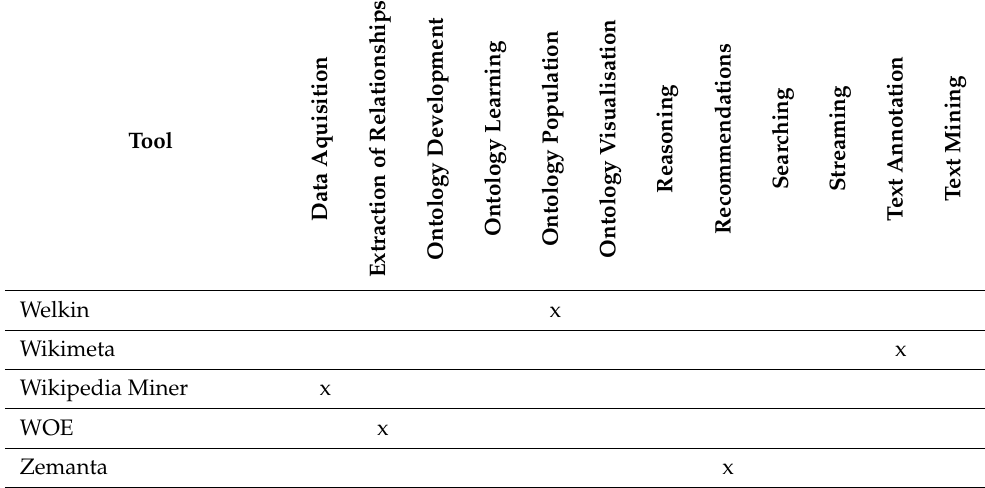
Table 4. Selected characteristics of the tool (tools 1–35).